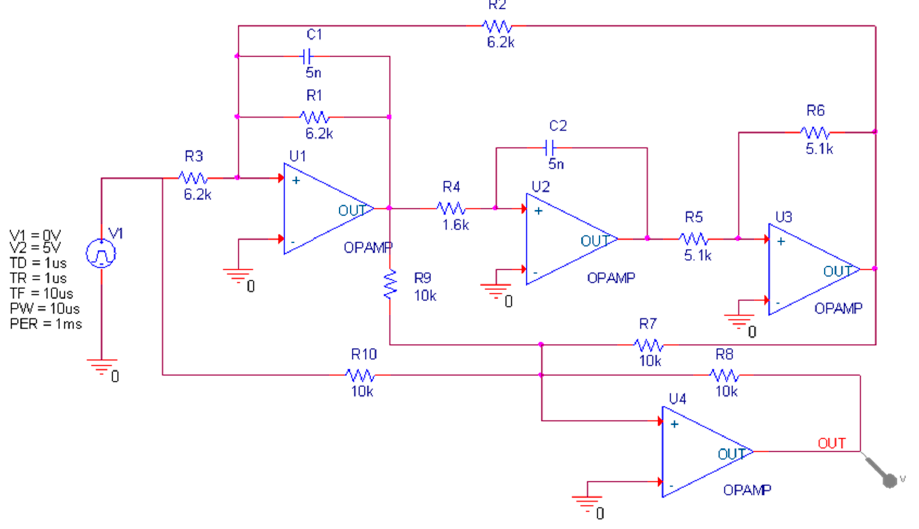
Figure 5. Four-opamp biquad high-pass filter circuit.